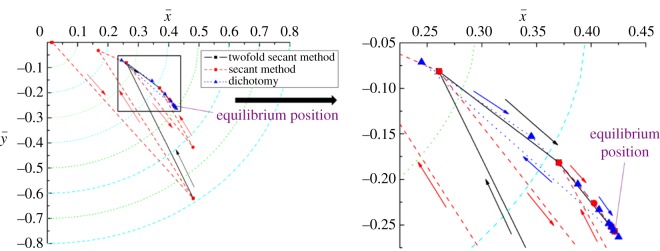
Convergence for the equilibrium position, Lb = 0.1 m.